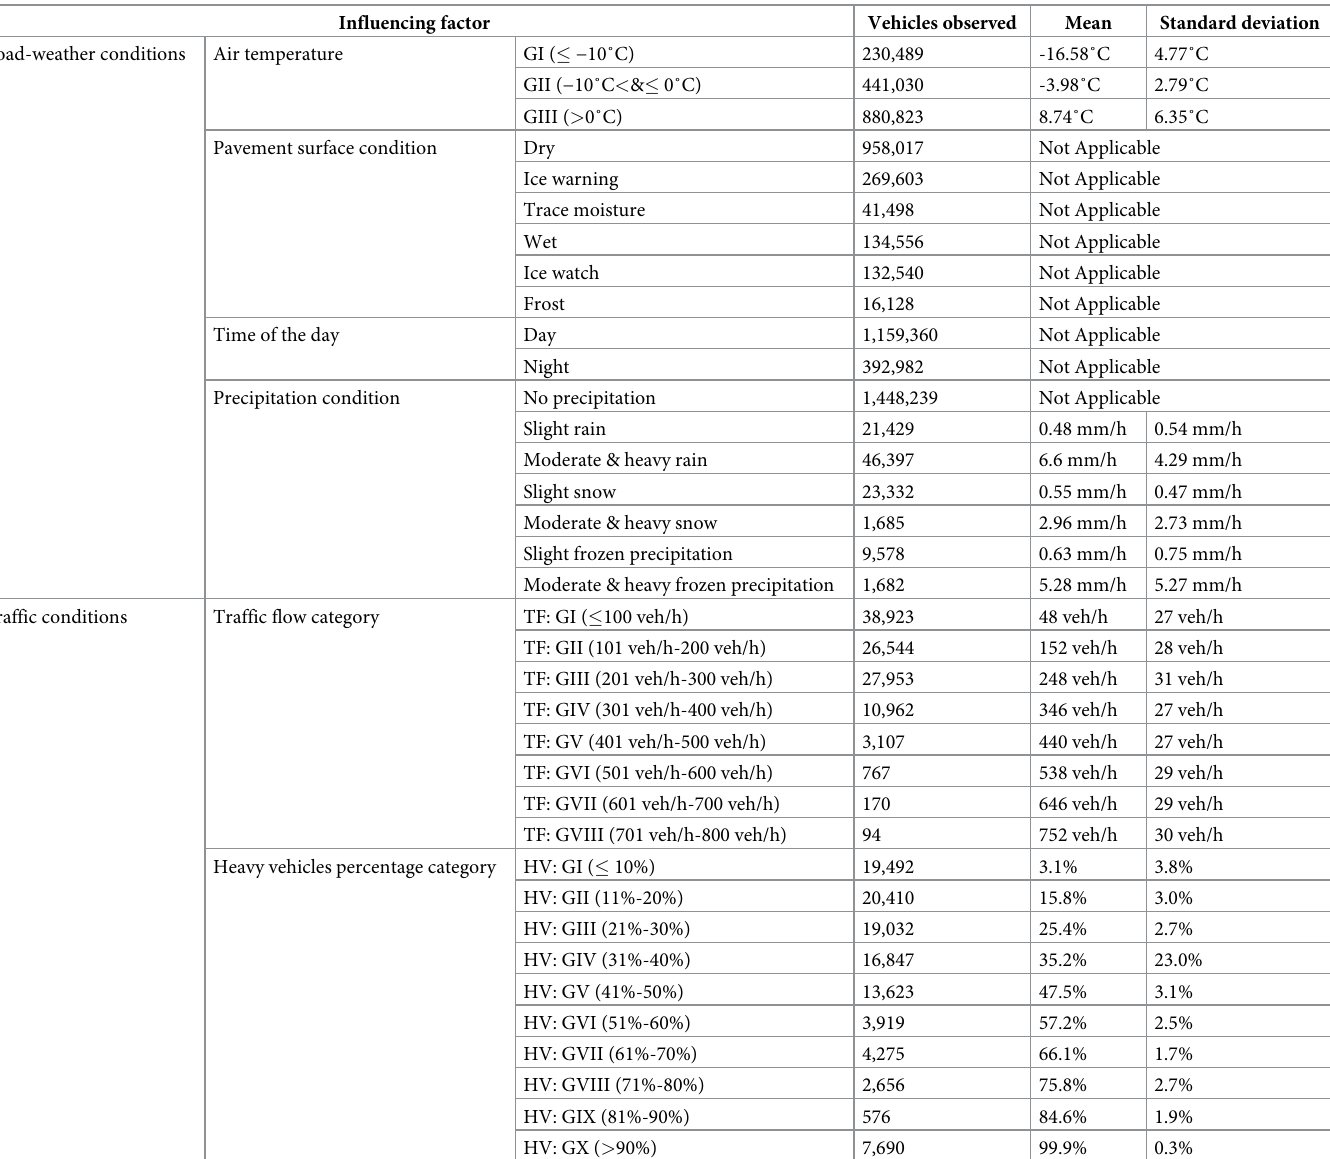
Table 2. Summary statistics of influencing